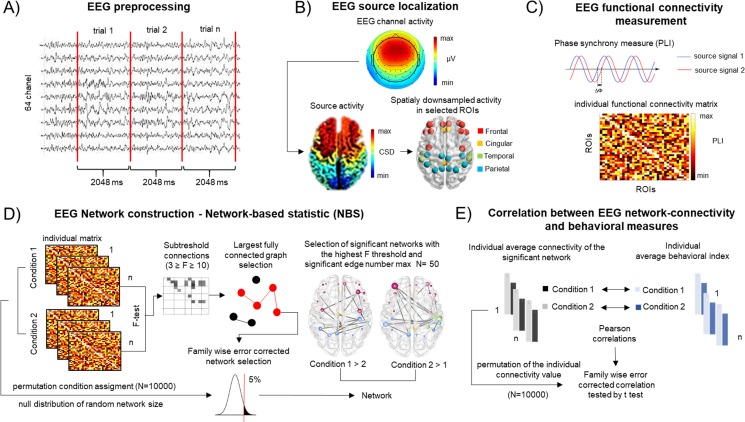
Schematic illustration of the data analysis.A) EEG preprocessing. Following primary filtering and ICA based artefact removal data was segmented. Epoch including target or non-target events or responses were excluded. Next, secondary artifact rejection (using threshold of 100 μV) was performed; B) EEG source localization. A minimum norm estimates model (sLORETA) for source-reconstruction was used together with forward boundary element head model (based on default anatomy and EEG locations); Current source density source activity was reconstructed for each voxel defined by the standardized parcellation scheme introduced by Klein & Tourville (2012). Finally, time-varying source signals was spatially down- sampled to the selected 36 ROIs; C) EEG functional connectivity measurement. Data were filtered for five frequency bands (from delta to gamma) and the phase lag index (PLI) was calculated as a measure of phase synchronization between each ROIs time series yielding 36 × 36 functional connectivity matrices for each individual, condition, and frequency band; D) EEG Network construction—Network-based statistic (NBS). An F test of each experimental contrast was run for each connection, and above-threshold connections selected for an F range between 3 and 10. The algorithm then searched for the largest fully connected network on each threshold level. Distribution of network size was pulled from the permutation of condition assignments (N = 10000). Family-wise error corrected p values of each network were obtained by comparing the network to the distribution derived from the random networks. Finally, the significant network on the highest F threshold level with only significant edges was selected (the maximum number of edges was set to 50); These networks were divided into two subnetworks according to the direction of the contrast effect. E) Correlation between EEG network-connectivity and behavioral measures. The average connectivity of the significant network emerging from each statistical contrast was correlated with the average behavioral indices (d, RT, recognition performance) of the corresponding condition. Family-wise error was controlled for each behavioral variable by estimating the distribution of the correlation coefficients via permuting the values of the network strengths 10,000 times.